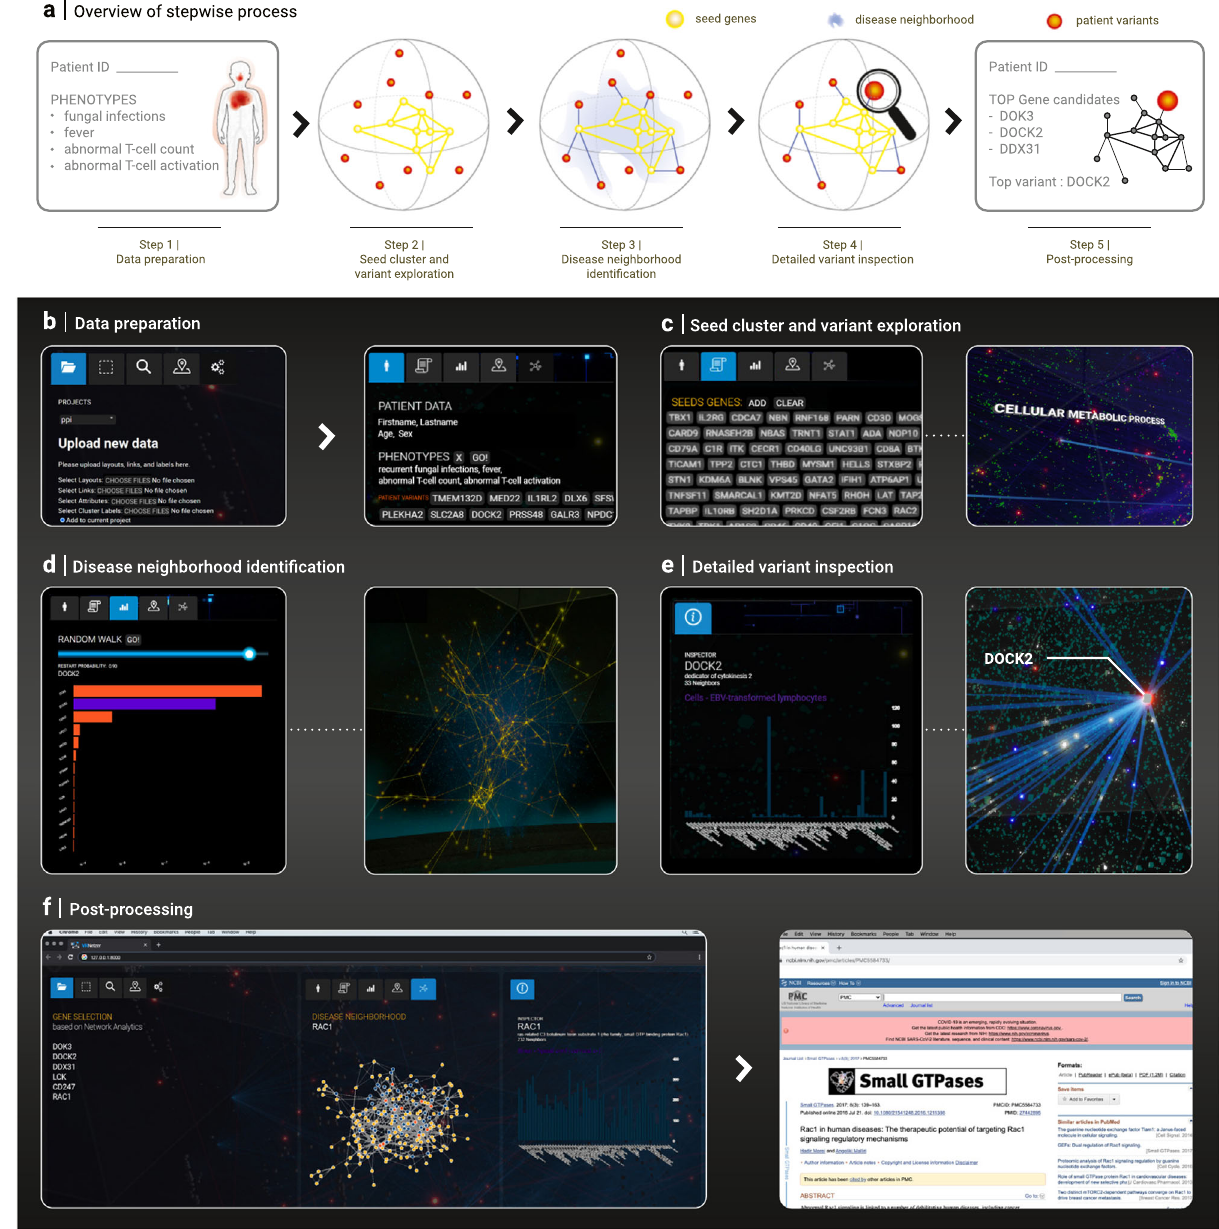
Fig. 5 Using the platform for prioritizing genomic variants of a rare disease patient. a Overview of the different steps of the procedure, from collecting relevant data in the web module to performing interactive network analyses in VR and fi nally post-processing the results. b – f Screenshots illustrating the individual prioritization steps. b The required data (patient phenotypes and candidate genes, seed genes, network data) are collected and curated using the web interface. All data are immediately available also in the VR environment thanks to the shared data module infrastructure. c Individual candidate genes (red) and seed genes are inspected in their network context to identify related biological functions and known disease associations. For example, the blue links show a connection between the candidate gene DOCK2 and cellular metabolic processes in the functional landscape corresponding to GO biological processes. d The broader network neighborhood around the seed genes is identi fi ed using a random walk with restart algorithm, providing a provisional and purely network-based ranking of the candidate genes. Left: inspection panel showing a bar plot of the resulting visiting frequencies of the 13 candidate genes. Right: the seed genes (yellow) are signi fi cantly connected, indicating a particular network neighborhood associated with the respective disease. e Detailed inspection of the most highly ranked candidate genes according to known functions and disease associations within their network neighborhood. Left: Inspection panel showing expression levels of DOCK2 across different tissues. Right: Connections of DOCK2 in the network view. f , Saving the key results of the VR exploration for further inspection and follow-up analyses in the web module. Left: Screenshot of the web module summary of the VR session. Right: Following up on a particular interaction partner of DOCK2, RAC1, in